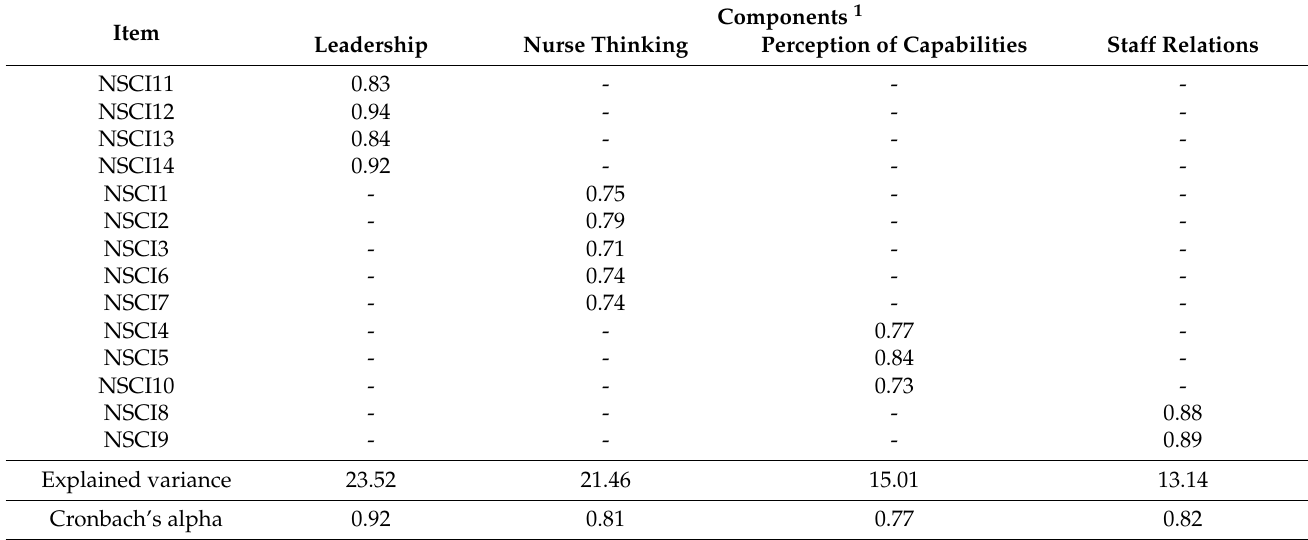
Table 2. Rotated component matrix.